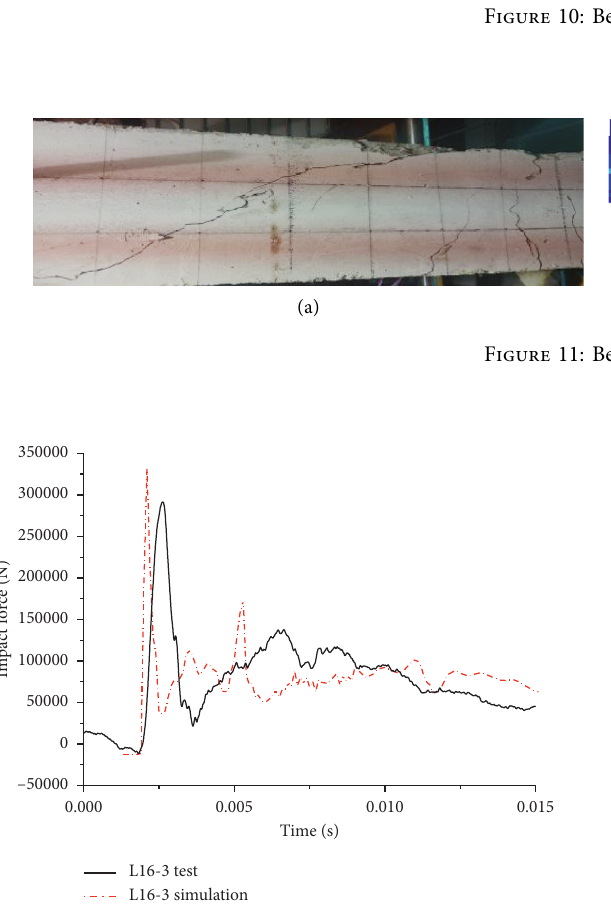
Figure 12: Time-history curves of the impact force. Figure 13: Time-history curves of the